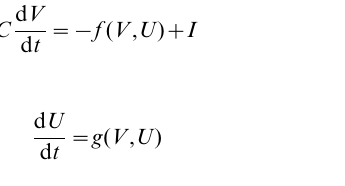
Figure S1 Information transmission through networks with gain-scaling neurons G Na = G K ~ 1 : 0 ( G K ~ 1000 pS/ m m 2 and G Na ~ 1000 pS/ m m 2 ). A. PSTHs from each layer in two networks with different connectivity: left, weak synaptic strength g syn ~ 0 : 016 ; right, stronger synaptic strength g syn ~ 0 : 03 . The PSTHs demonstrate that the propagation of a slow-varying input in the presence of a background of fast fluctuations degrades in deeper layers, similar to the gain-scaling networks in Figure 6 of the main text, where G Na = G K ~ 1 : 5 . PSTHs were normalized to mean 0 and standard deviation 1 so that the dashed lines next to each PSTH denote 0 and the scalebar 2 normalized units. B. Spike rasters for the PSTHs in A. C. Information about the slow stimulus fluctuations conveyed by the population mean responses shown in A, compare to Figure 4D of the main text. Figure S2 Firing rate transmission for different con- nection probability and synaptic strength. Top: The f – I curves (green) for gain-scaling network with G Na = G K ~ 1 : 5 ( G K ~ 1000 pS/ m m 2 and G Na ~ 1500 pS/ m m 2 ) and nongain- scaling networks with G Na = G K ~ 0 : 6 ( G K ~ 1000 pS/ m m 2 and G Na ~ 600 pS/ m m 2 ) with a noise level of s ~ 50 pA. The black lines denote the linear input-output relationships (slope 1 = a ) derived from the mean field which predict how the mean output firing rate of a given network layer can be derived from the mean input current into that layer, with the standard deviation of the prediction shown in gray. Note that within each of the four columns the slope of the linear prediction is identical, despite individual changes in the connectivity probability E and the synaptic strength g syn . Three bottom row panels show the transmission of mean firing rates for a range of mean input currents as a function of layer number–each row of panels illustrates the outcome for different connection probability, E ~ f 0 : 5,5,10 g % , while also varying the strength of synaptic connectivity ( g syn ) to preserve their product. Network